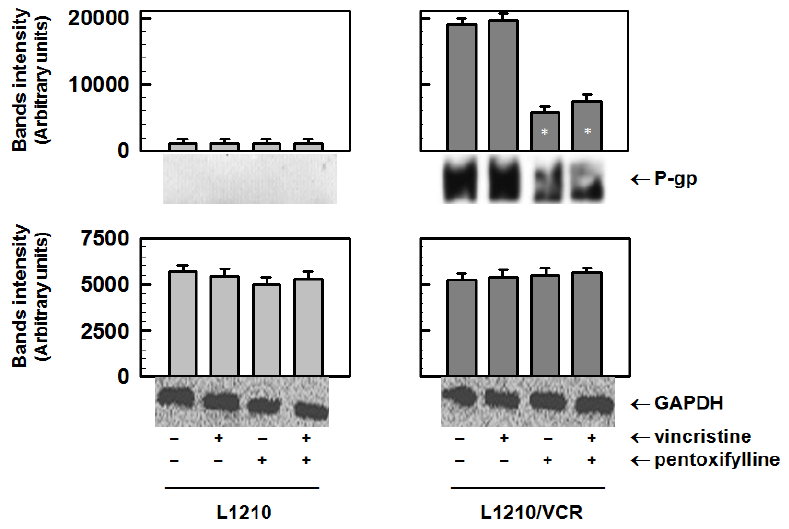
Figure 1. Reduction of P-glycoprotein (P-gp) protein levels by pentoxifylline (PTX). P-gp protein levels were analyzed L1210 and L1210/VCR cells treated with 1.2 μmol/L vincristine (VCR) and/or 100 μmol/L PTX for 24 h. The protein levels of P-glycoprotein and GAPDH (housekeeper) were determined by Western blot analysis using specific antibodies. Blots of three independent experiments were quantified and obtained data were evaluated by Student’s t test. Data represent means ± SD. * Different from control (without drugs) at significance level p <